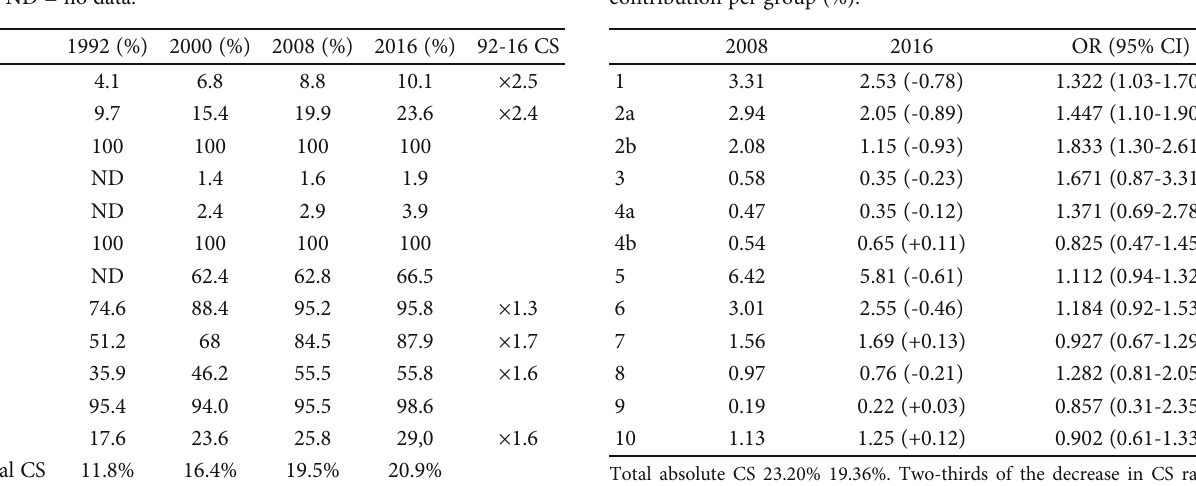
Table 6: Robson ’ s 10-Group Classi fi cation of a selected group of Flemish women giving birth in 2008 and 2016: Cesarean section contribution per group (%).